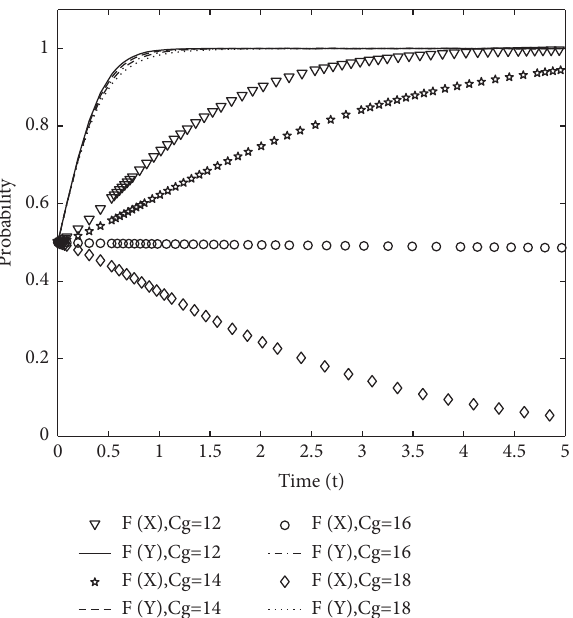
Figure 6: . Evolutionary path of C